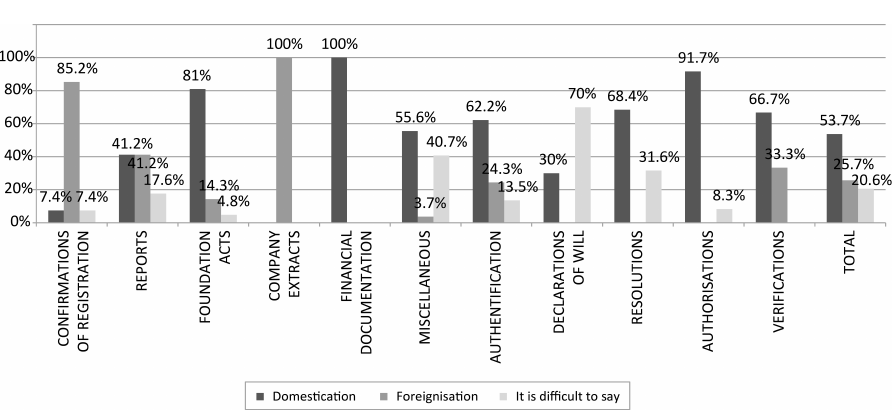
Figure 1. Distribution of the translation strategies in relation to the categories